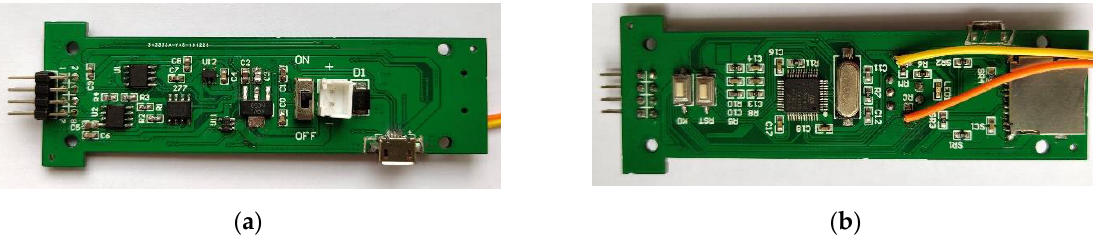
Figure 7. Analog voltage amplification and acquisition circuit: ( a ) front of the circuit board; ( b ) back of the circuit board. The clamping mechanism for fixing the circuit board and the battery in the probe rod is shown in Figure 8.